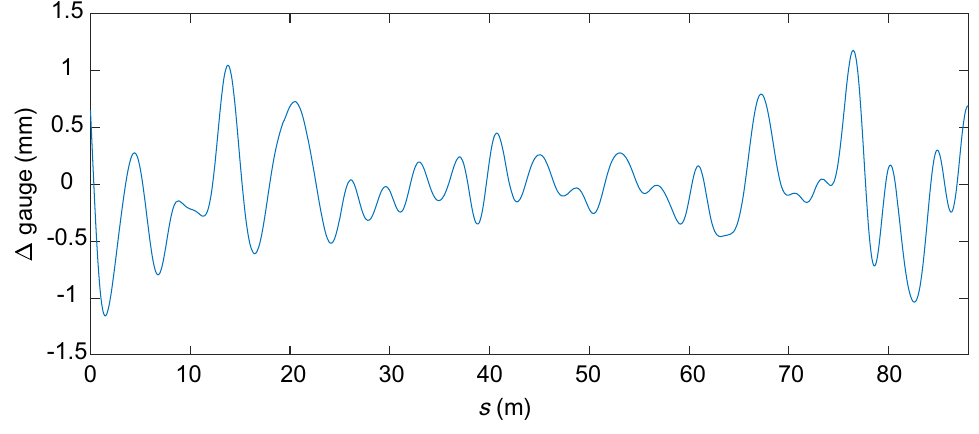
Figure 17. Filtered scaled track gauge deviation.